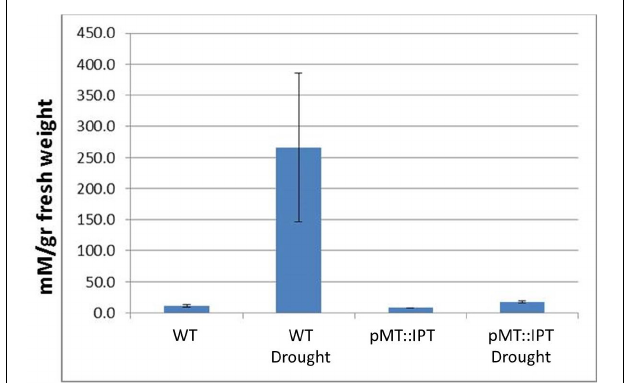
FIGURE 3 | Proline content in pMT:IPT and WT tobacco plants under drought stress. Proline content was determined in leaves taken from mature, 3-month old tobacco plants subjected to drought stress (water withholding for 3 weeks). Proline content was determined by colorimetric assay. Asterisk refers to statistically significant difference between treatments ( p < 0.05). Values correspond to means ± SE of three independent experiments.